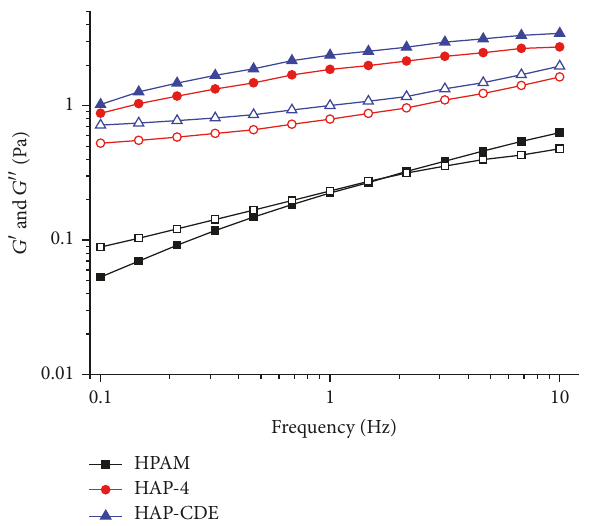
Figure 4: Dynamic viscoelasticity of the three polymeric systems. Closed symbols denote storage moduli and open symbols denote loss moduli (0.2 wt%, 25 ∘ C).